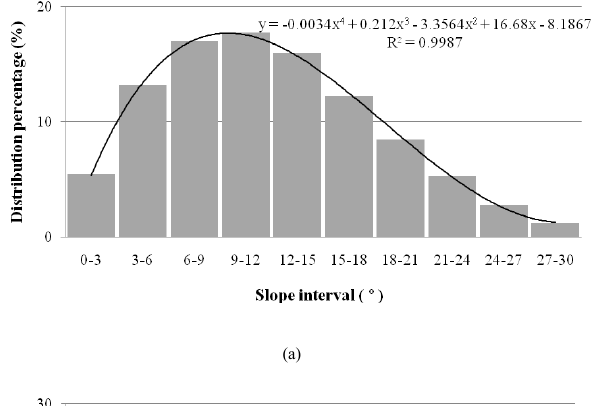
Based on Fig. 5, overlapped with the classified slope data